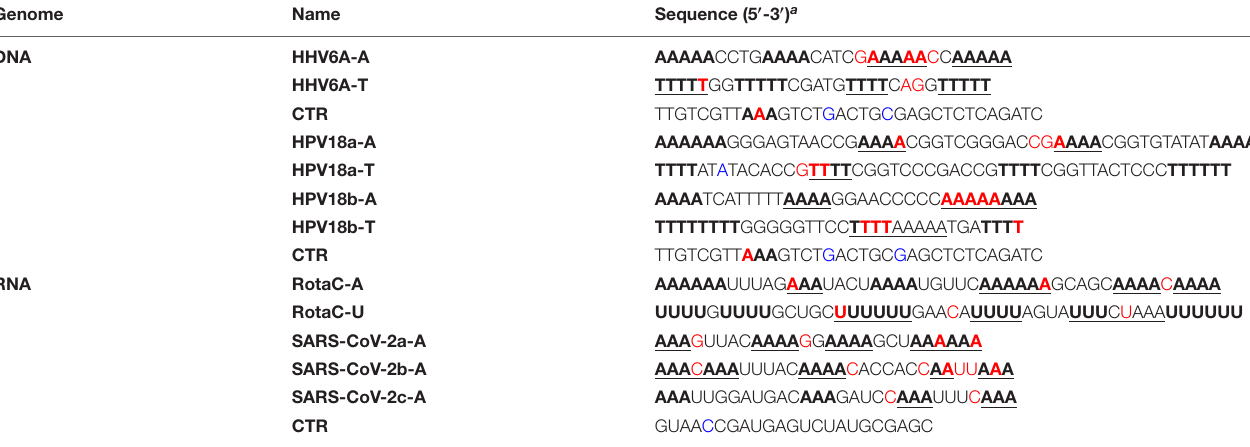
TABLE 2 | Summary of identified stop sites within viral templates. Genome